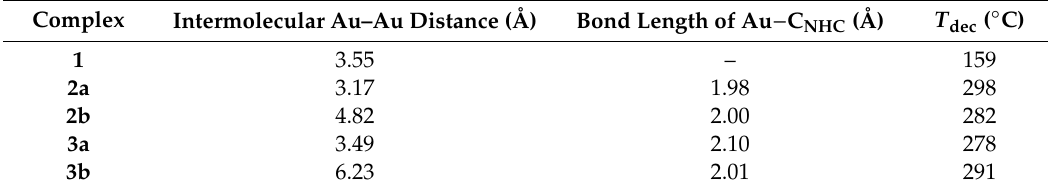
Table 1. Intermolecular distance between neighboring Au atoms in the crystal and thermal decomposition temperature ( T dec ) of Au complexes.